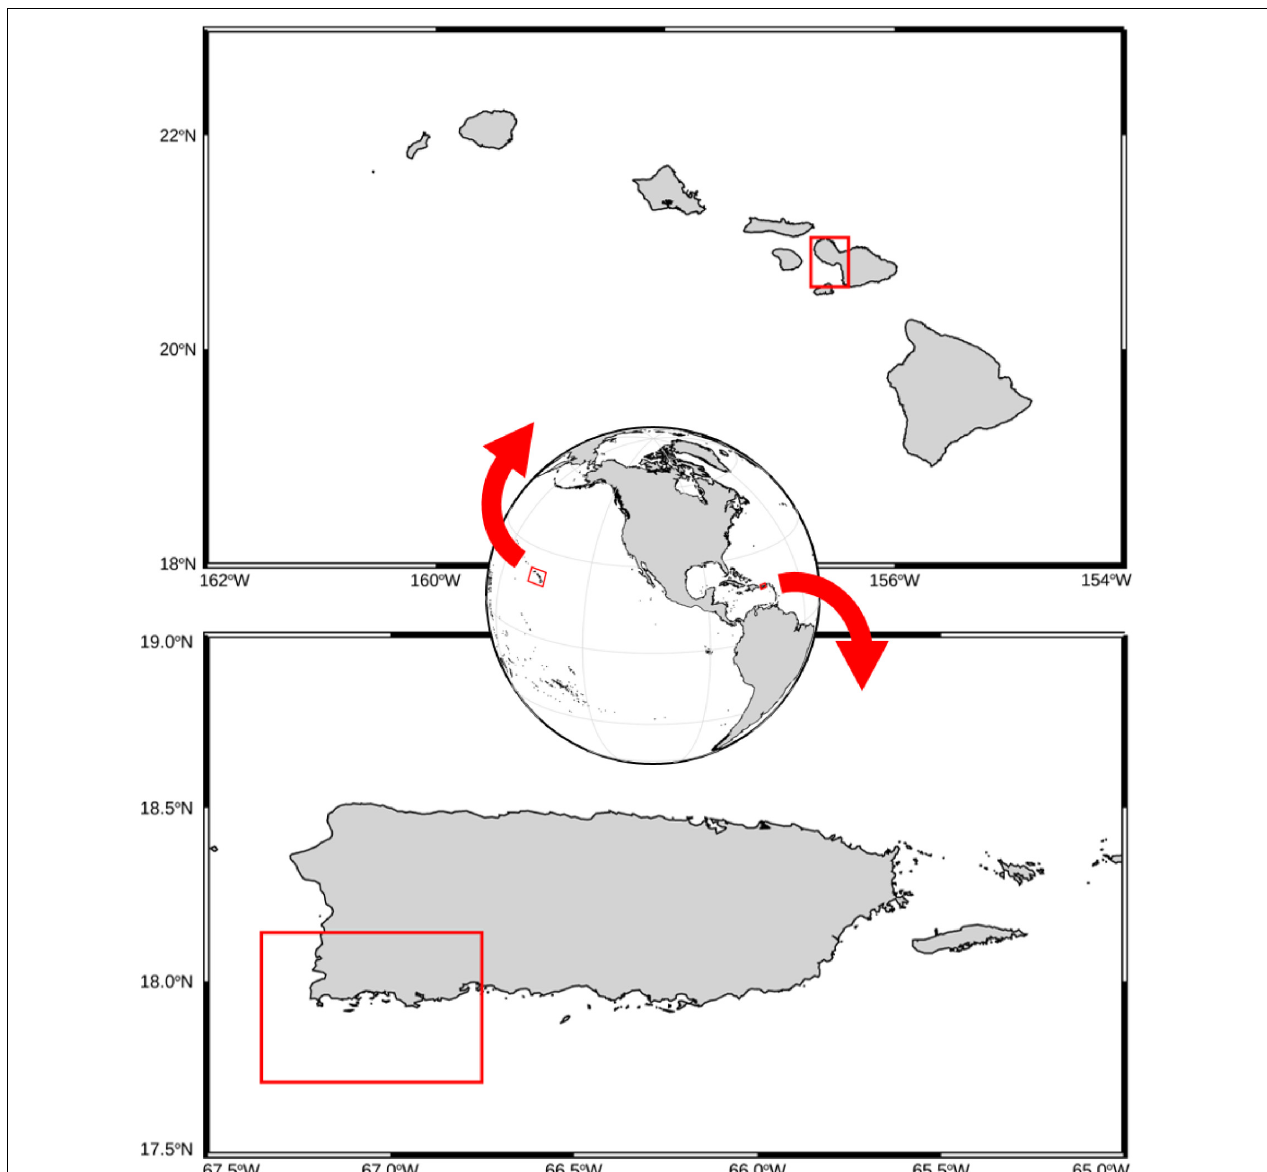
FIGURE 1 | Location of study areas (red boxes) in West Maui, Hawai‘i (top) and southwestern Puerto Rico (bottom)